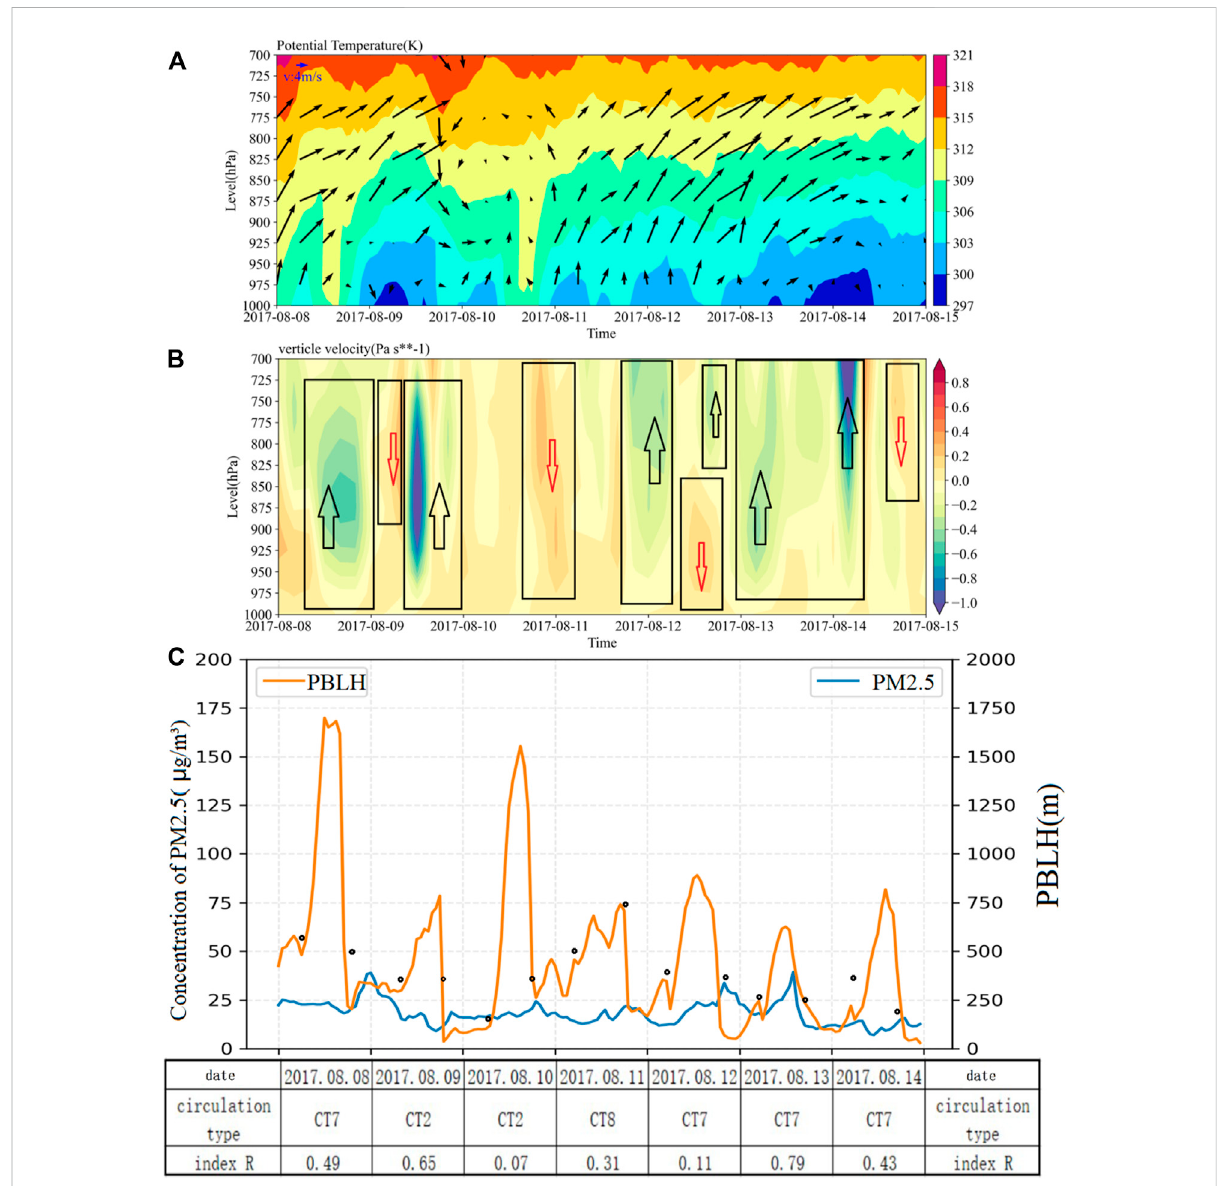
FIGURE 13 Plotsshowingarecirculation processthatoccurredinChangshainAugust2017. (A) Timeseriesofthevertical geopotentialtemperature pro fi le andthehorizontalwind fi eldintheChangshaareaduring therecirculationprocess. (B) Timeseriesoftheverticalwindspeed pro fi leintheChangsha area during the recirculation process, in which the red arrows represent downdraft, and black arrows represent updraft. (C) Time-dependent changes of the boundary layer height and PM 2.5 concentration, as well as daily circulation patterns and R values in Changsha during the re fl ow process. Black dots represent the PBLH observed from the sounding data. The boundary layer height, geopotential temperature, horizontal wind fi eld, and vertical wind speed in the fi gure have been obtained from the output of the WRF